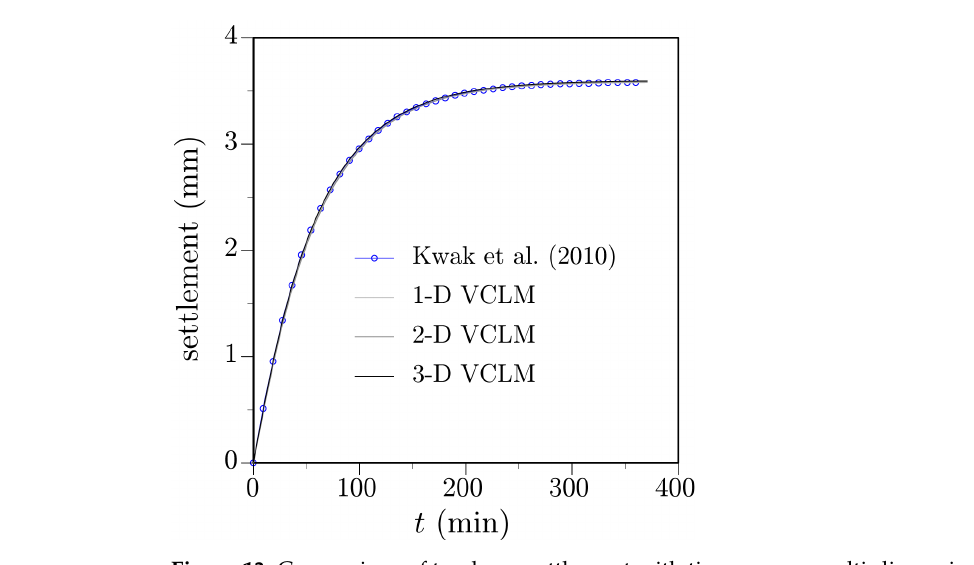
Figure 13. Comparison of top layer settlement with time among multi-dimensional VCLM meshes and original planar FE model of Kwak et al. [92].